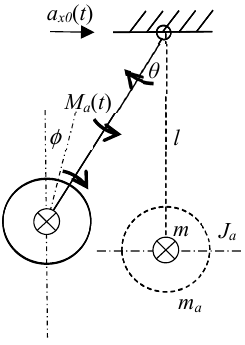
Figure 1. Simplified analysis model of the suspended structure with the ARID system.